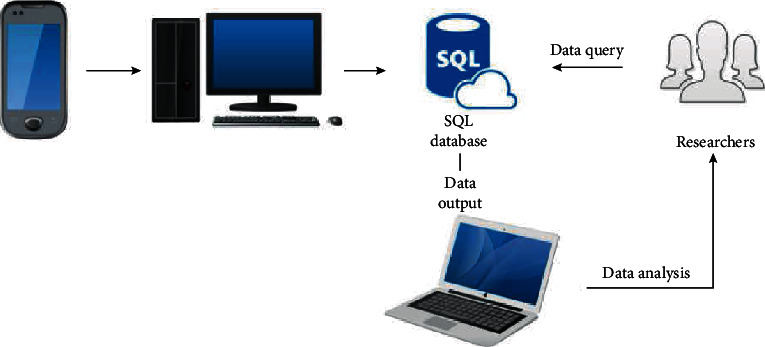
Penyikang recorded and sent data to the terminal computer, which further connected and restored data in the SQL database; researchers can access the SQL database with specific application requirements and analyze the output data. SQL: standard database language.